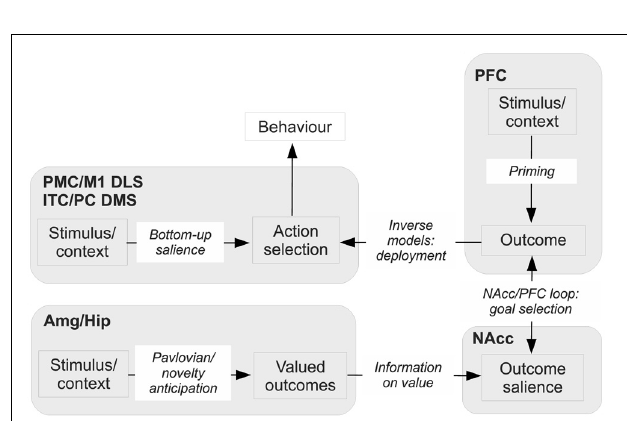
FIGURE 10 | Sketch of the main functional elements of the hypothesis, with their possible biological correspondents. Amg, amygdala; DLS, dorsolateral striatum; DMS, dorsomedial striatum; Hip, hippocampus; ITC, inferotemporal cortex; M1, primary motor cortex; NAcc, nucleus accumbens; PC, parietal cortex; PFC, prefrontal cortex; PMC, premotor